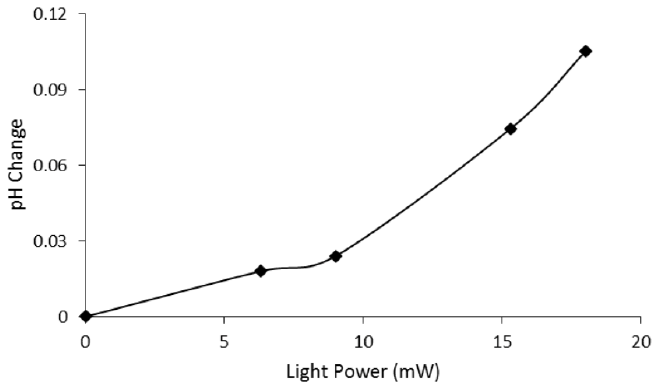
Figure 9. The change in steady-state pH of the solution in reservoir R1 as the intensity of light striking the bR-PAA transducer increases from 0 to 18